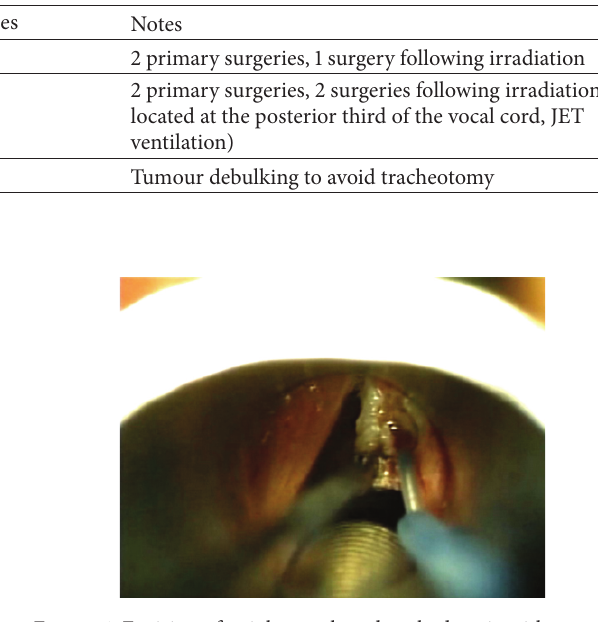
Figure 1: Excision of a right vocal cord pachydermia with a needle- tip RF